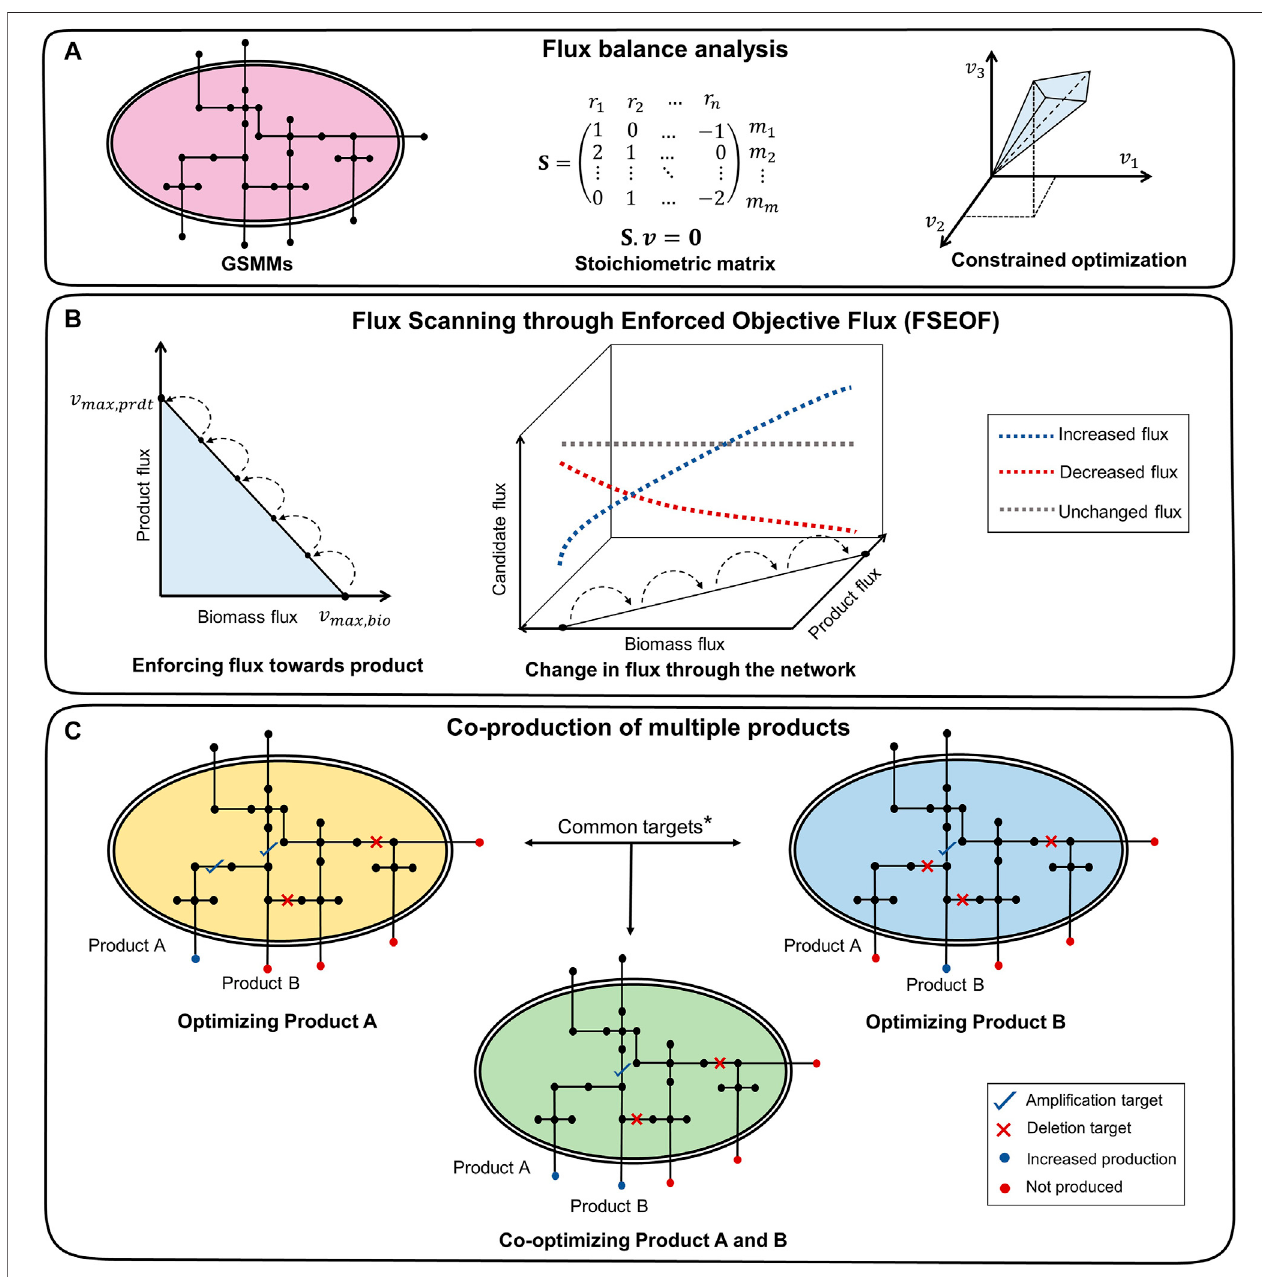
FIGURE1| Frameworkofco-FSEOF. (A) TheGSMMisrepresentedasastoichiometricmatrix,whichisusedforFBA. (B) The fl uxthroughtheproductisincreased insteps,and fl uxchangesthroughallotherreactionsarestudied.Thereactionsthathaveincreased fl uxwithanincreaseinproduct fl uxarepotentialampli fi cationtargets. Thereactionsthathavedecreased fl uxarepotentialdeletiontargets,whilethosewithunchangedoroscillatory fl uxesareexcluded. (C) Thetargetscommontoproducts A and B are the potential targets for co-optimization. *The union of all potential targets for products A and B is used for higher-order intervention strategies.